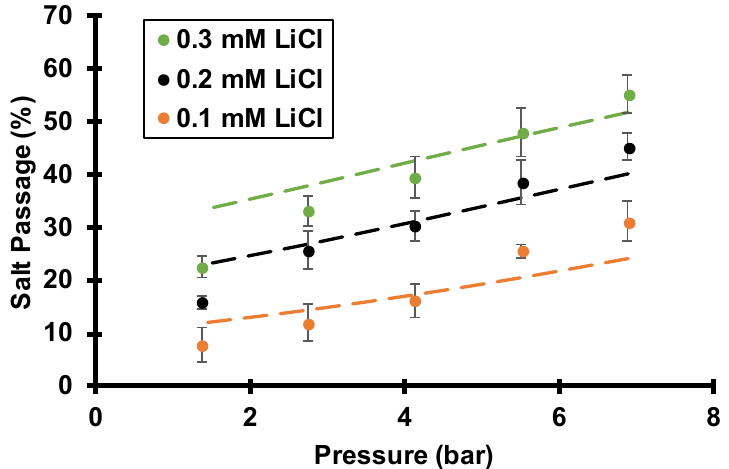
Figure 9. Salt passages during flow of LiCl solutions of various ionic strengths through track-etched membranes (30 nm pores) using various transmembrane pressures and a 1000 rpm rotation rate. Dashed lines are simulated passages assuming a surface charge density of − 2.2 mC/m 2 , a pore diameter of 30 nm, and a boundary layer thickness of 19.4 µm, as calculated from the Levich equation.